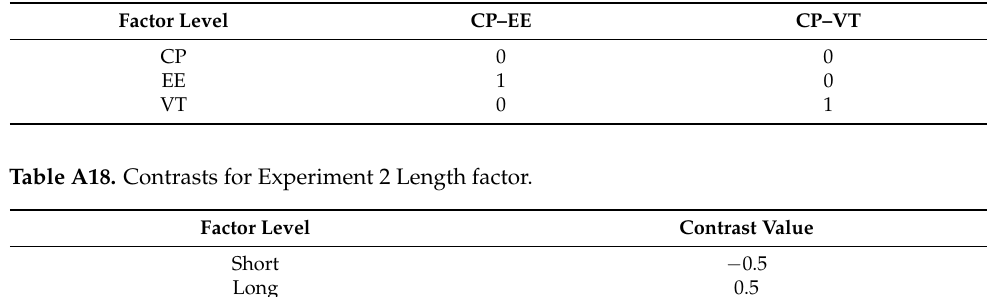
Table A17. Contrasts for Experiment 2 Verb type factor.